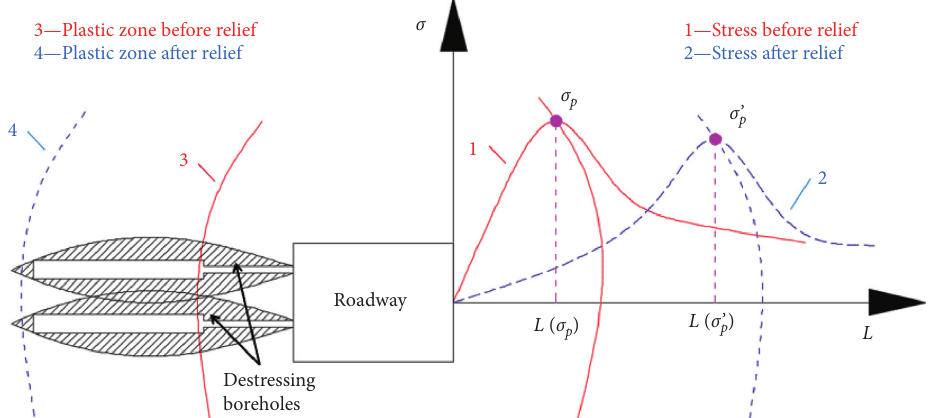
Figure 1: Mechanism of borehole